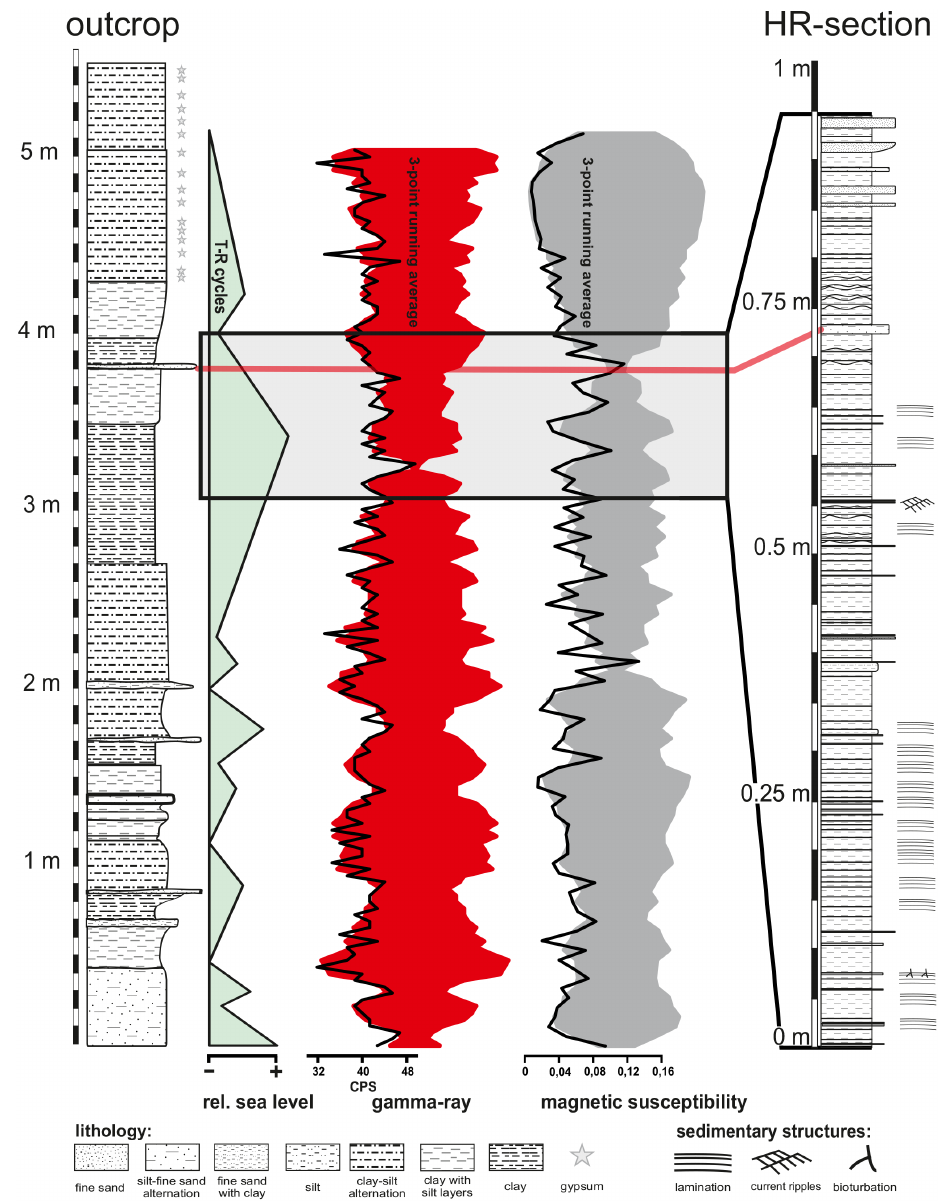
Figure 3. Lithologs of the 5.5m sedimentary succession and the high-resolution (HR) section. The position of the high-resolution section within the succession is marked by the grey rectangle; the red line denotes a distinct marker layer that was used as a tie point. Relative sea level was reconstructed using gamma-ray logs. Gamma-ray logs (in CPS) and magnetic susceptibility of the outcrop are shown as black lines. A three-point running mean for both logs was plotted as a mirrored column (after Auer et al.,